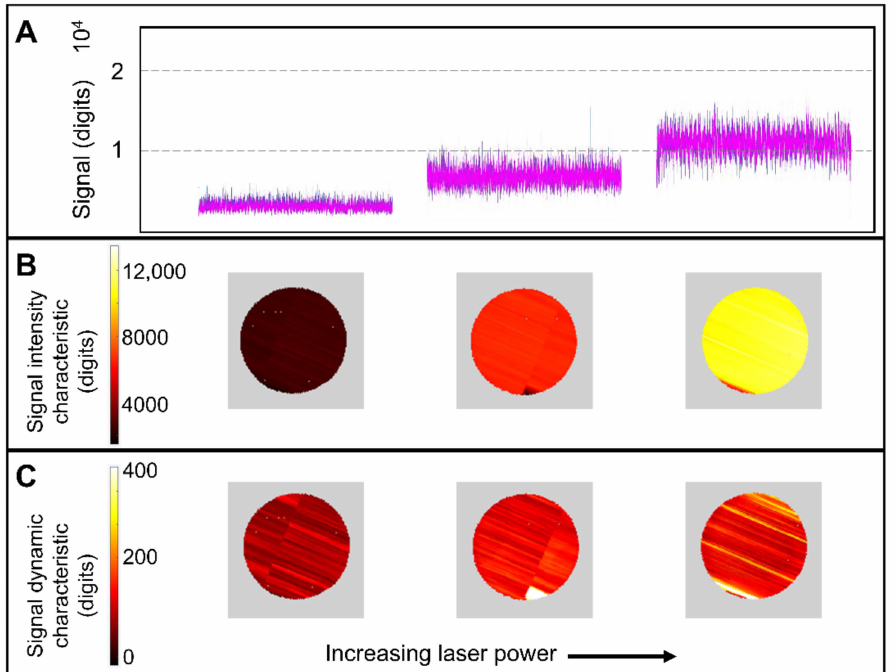
Figure 9. Results from melt pool monitoring of specimens with increasing laser power in the conduction regime sampled from the topmost layer of each specimen. Laser power of 100 W, 200 W, and 300 W, and otherwise identical parameters (nominal laser scan speed 1000 mm/s and layer thickness 40 µ m). ( A ) Raw signal in temporal x-coordinate. Spatial representation of the intensity ( B ) and dynamic signal characteristics ( C